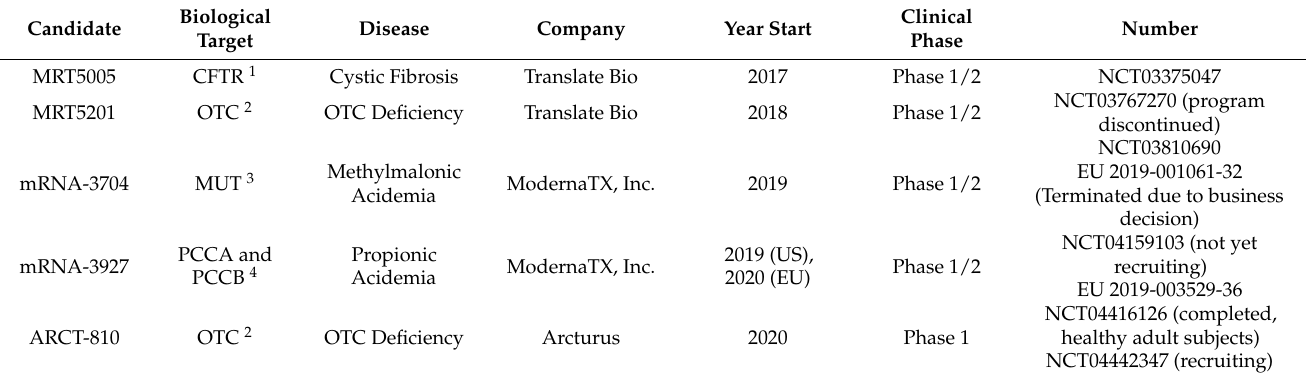
Table 3. LNP-mRNA-based RNA protein replacement clinical studies (as of February